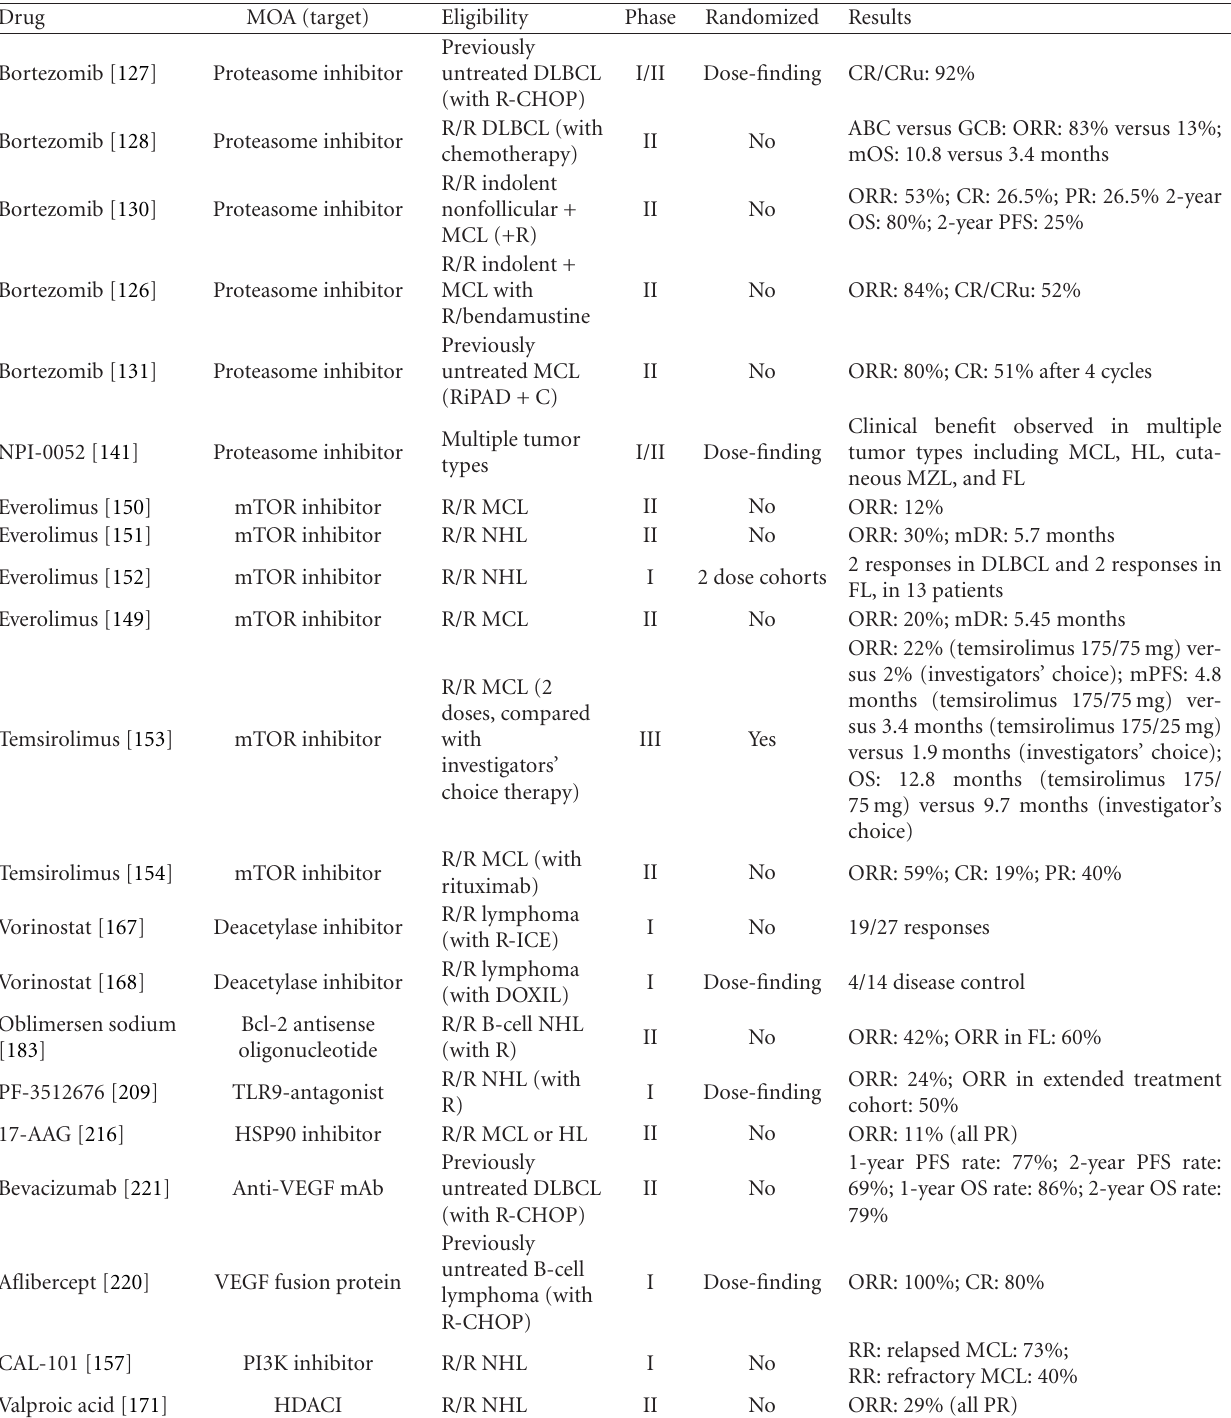
Table 5: Targeted therapies in clinical development for the treatment of aggressive NHL. [ABC: activated B-cell-like DLBCL; CR: complete response; CRu: unconfirmed CR; DLBCL: di ff use large B-cell lymphoma; FL: follicular lymphoma; GCB: germinal-center B-cell-like DLBCL; HDACI: histone deacetylase inhibitor; HL: Hodgkin lymphoma; Hsp: heat shock protein; mAB: monoclonal antibody; MCL: mantle cell lymphoma; mDR: median duration of response; MOA: mechanism of action; mOS: median overall survival; mPFS: median progression- free survival; mTOR: mammalian target of rapamycin; MZL: marginal zone B-cell lymphoma; NHL: non-Hodgkin lymphoma; ORR: overall response rate; OS: overall survival; PI3K: phosphatidylinositol 3-kinase; PFS: progression-free survival; PR: partial response; R: rituximab;